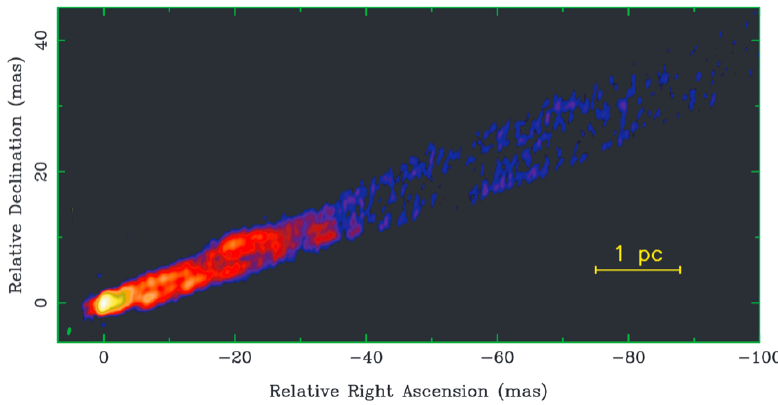
Figure 1. Very Long Baseline Array (VLBA) 15 GHz (2 cm) image of M87. The swirling jet substructure (twisting about the jet axis) may be indicative of magnetic Kelvin–Helmholtz instabilities. Image adapted with permission from Dan Homan, Yuri Kovalev, Matt Lister, and Ken Kellermann.